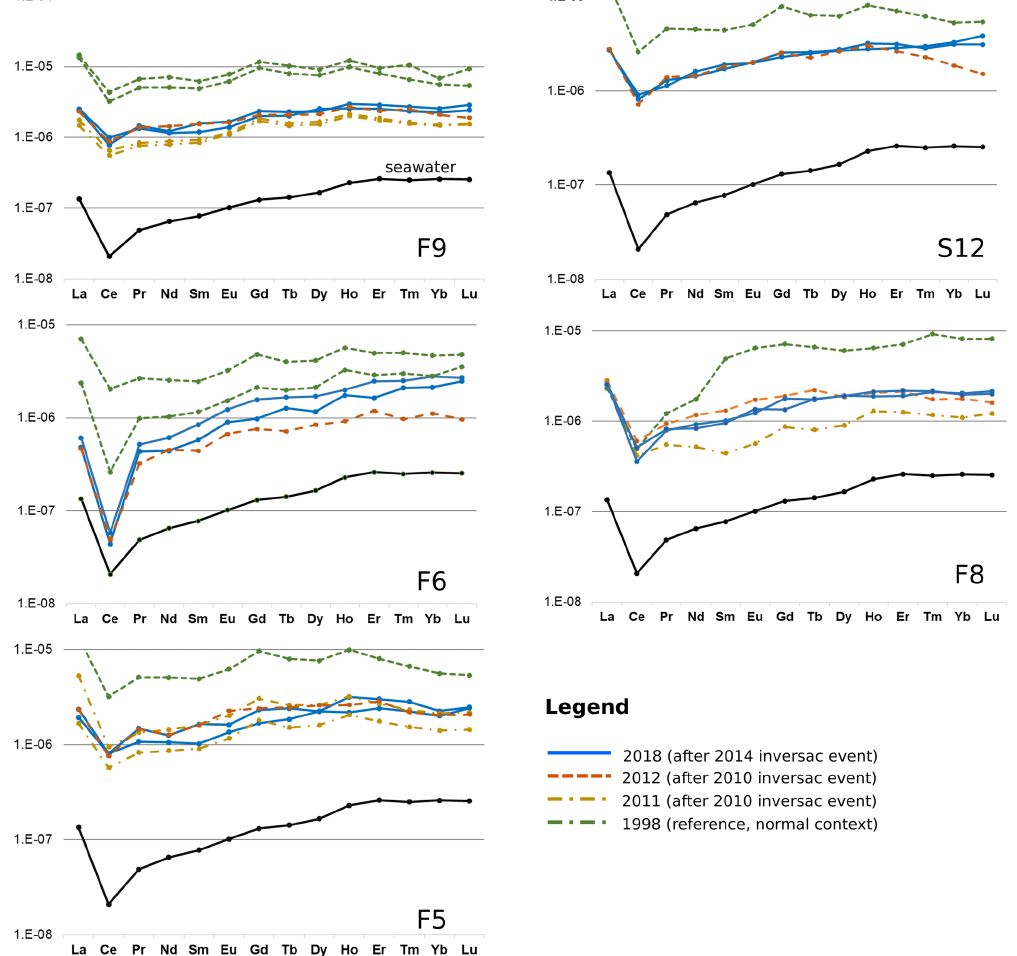
Figure 7. REE profiles for thermal wells at different times: the 1998 data are for the pre-inversac reference state, whereas the 2011, 2012, and 2018 profiles are for the three post-inversac